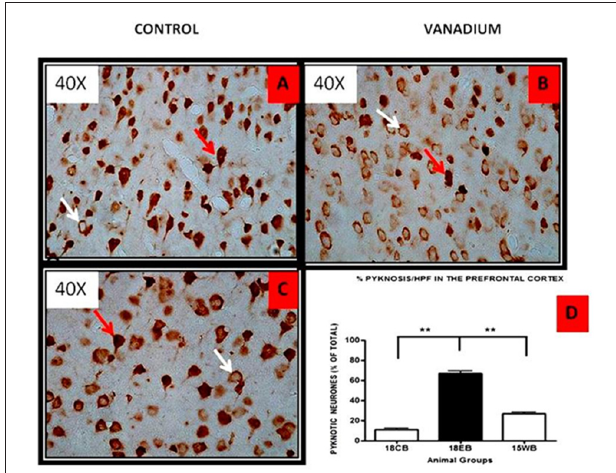
FIGURE 7 | HPF photomicrographs showing the pyramidal cells of the prefrontal cortex using the NeuN immunohistochemistry. No remarkable abnormality was observed in the cortical sections from animals of the control groups. The normal neurons were identified by their rounded and pale nuclei (see A red arrow), whereas degenerating neurons had smaller cell bodies and pyknotic nuclei (see B white arrow). There was evidence of vacuolation of neuropil surrounding the degenerating neurons. The withdrawal brain (C) showed less cellular pathology relative to the exposed brains. Quantitative analysis (D) showed that the mean % pyknosis of vanadium exposed groups were significantly ( ∗∗ P < 0.001) elevated relative to the control brain while the withdrawal groups were significantly ( ∗∗ P < 0.001) less than vanadium exposed groups. Magnification: ×